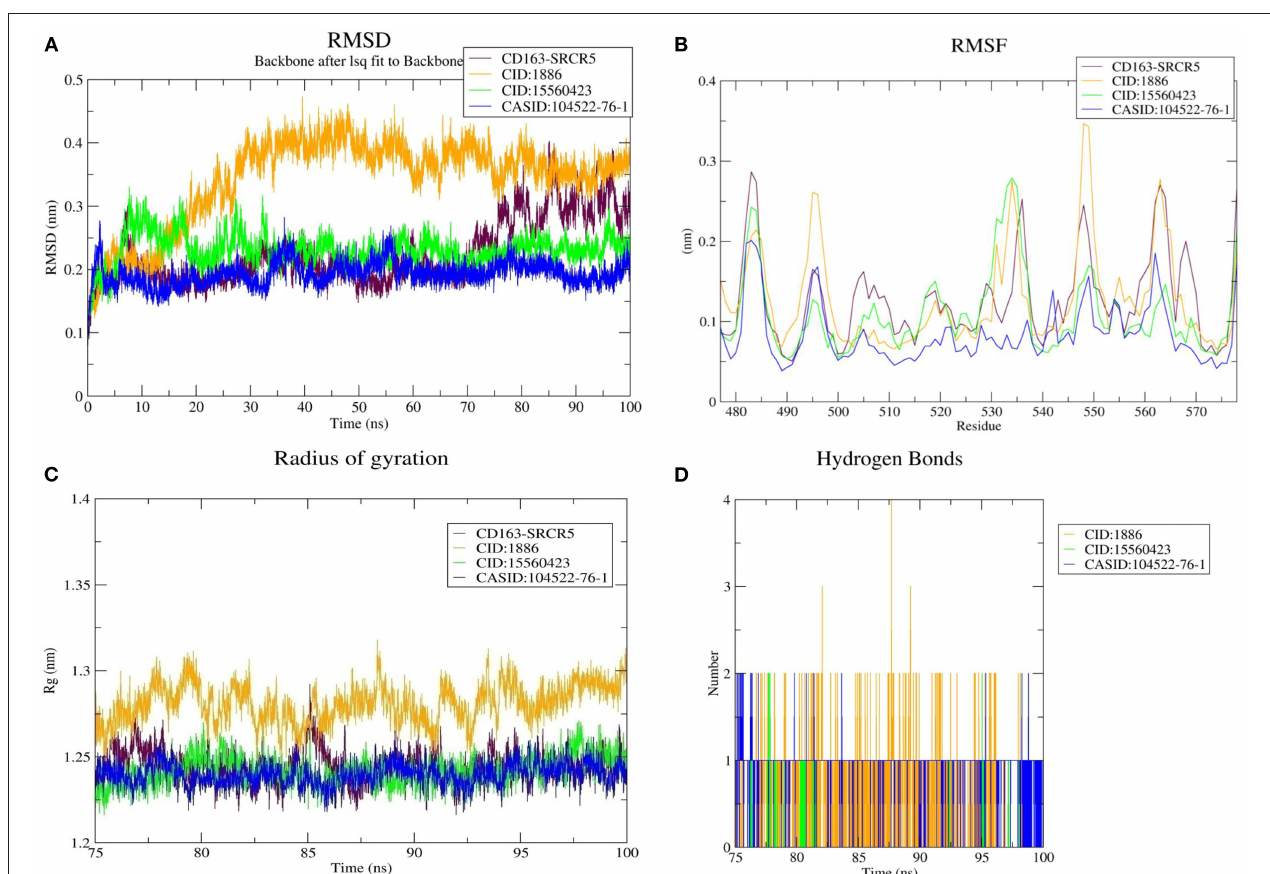
FIGURE 3 | MD simulation results. (A) Root mean square deviation (RMSD) plot of CD163-SRCR5 and the CD163-SRCR5-phytochemical complexes, (B) root mean square fluctuation (RMSF), and (C) radius of gyration (Rg) plots of the CD163-SRCR5 and CD163-SRCR5-phytochemical complexes over the final 25 ns of the MD simulations. Maroon, orange, green, and blue colors represent CD163-SRCR5, CD163-SRCR5-CID:1886, CD163-SRCR5-CID:15560423, and CD163-SRCR5–CASID:104522-76-1, respectively. (D) A plot showing the number of hydrogen bonds formed over the final 25 ns trajectory for each respective complex. Orange, green, and blue colors represent CD163-SRCR5-CID:1886, CD163-SRCR5-CID:15560423, and CD163-SRCR5–CASID:104522-76-1, respectively.